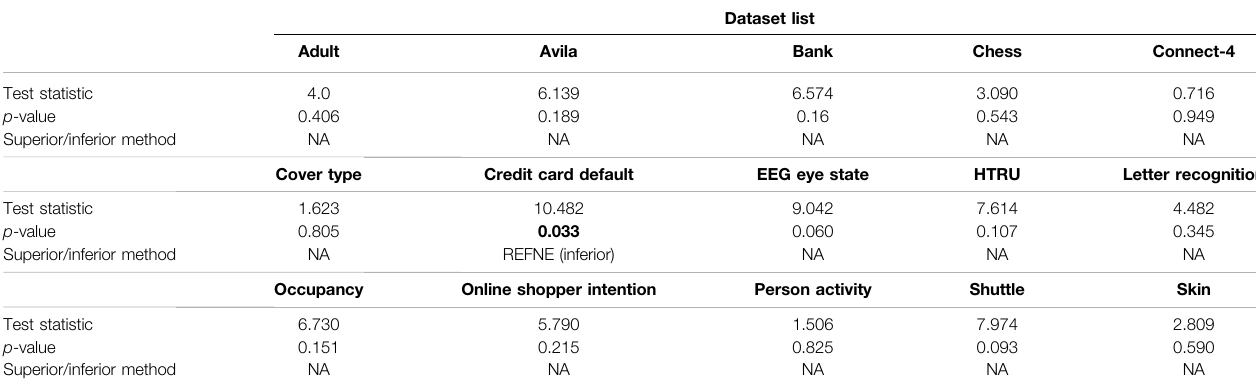
TABLE 5 | Output statistics and p -values of the Friedman test, grouped by dataset.